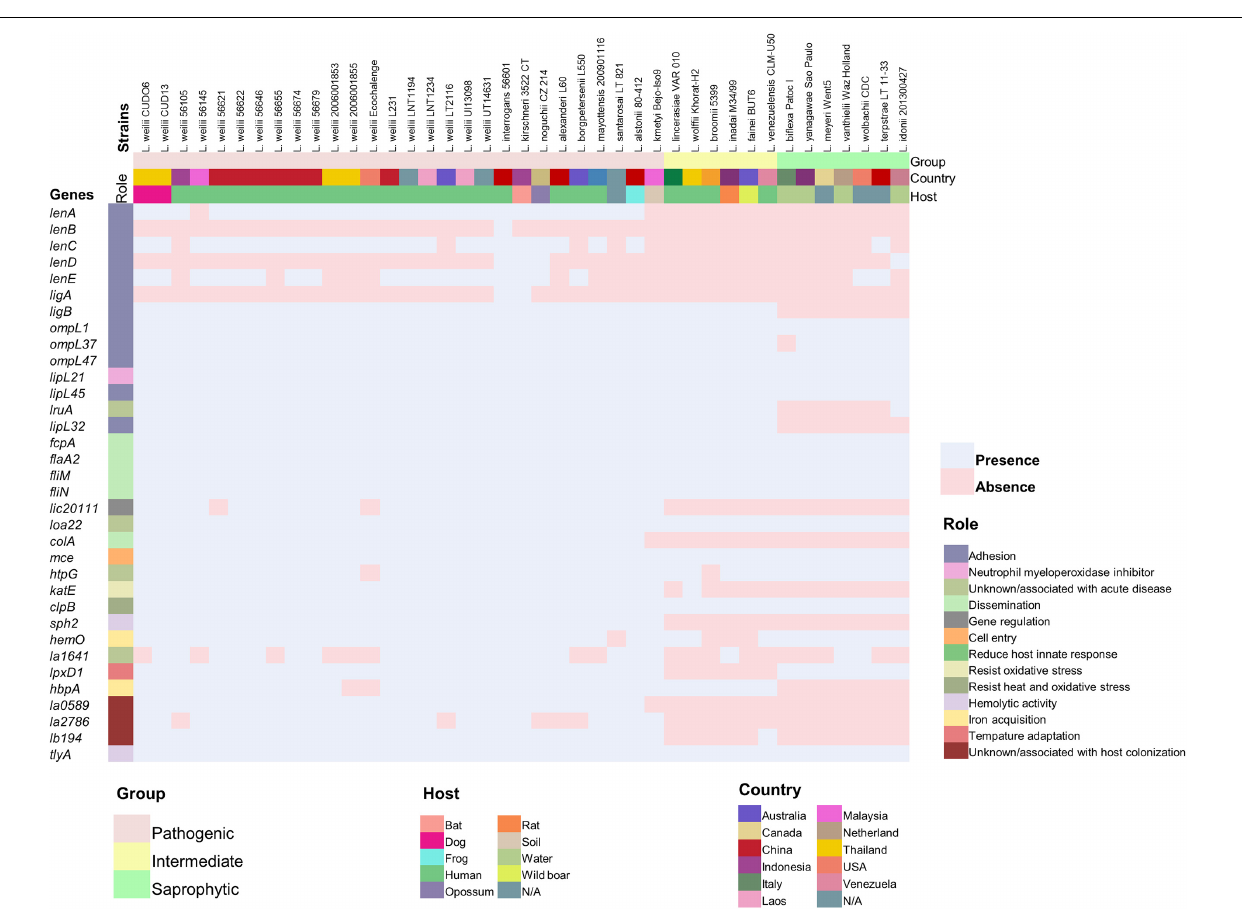
Frontiers in Microbiology |